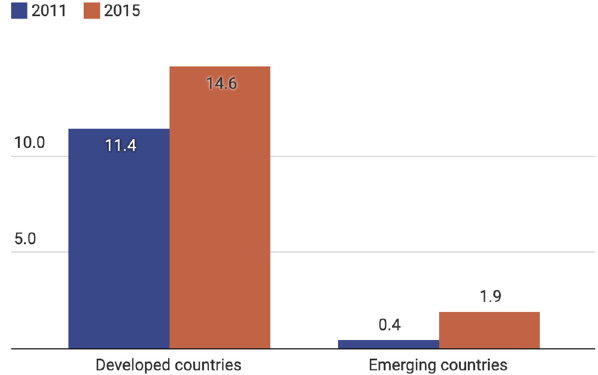
Table 1: The rising demand for robots worldwide